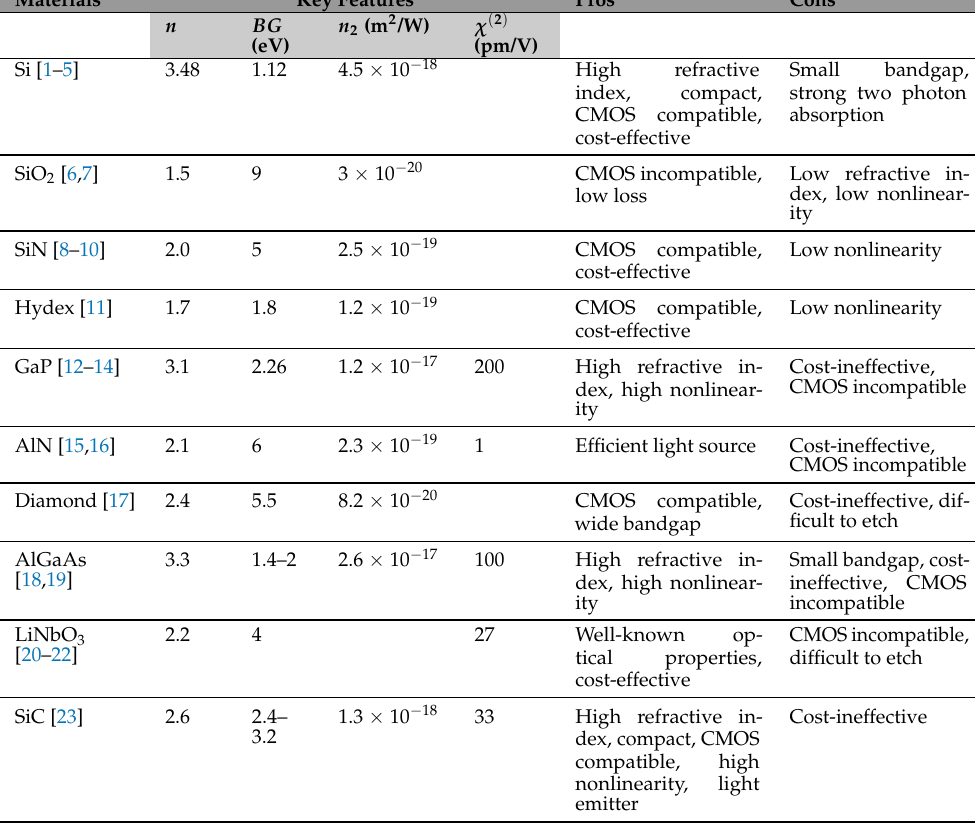
Table 1. Main material platforms for PICs. n : refractive index, BG : bandgap, n 2 : nonlinear refractive index, χ ( 2 ) : second-order